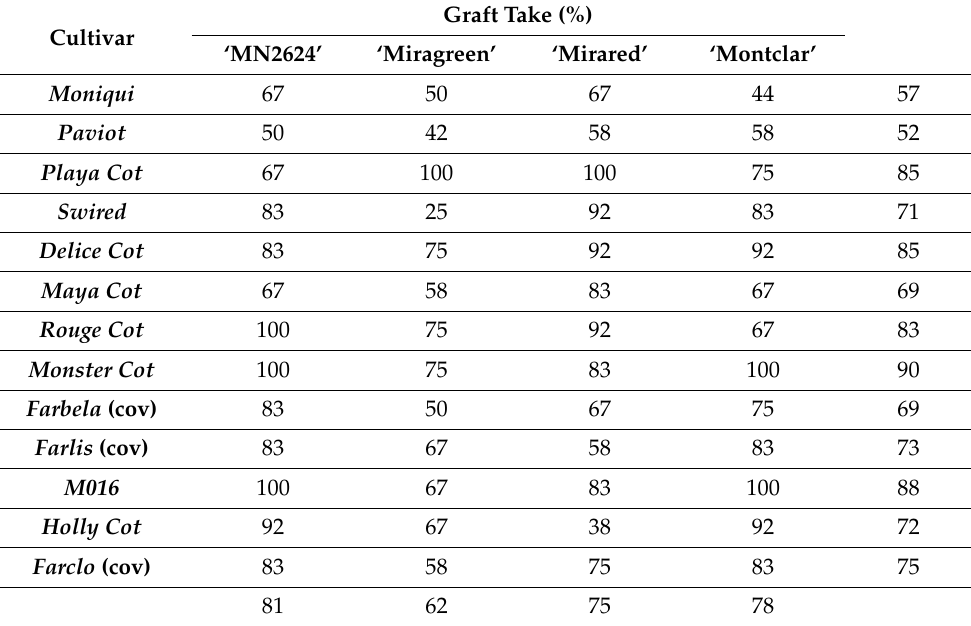
Table 3. Percentage of graft take sprouting at 42 DAG in all